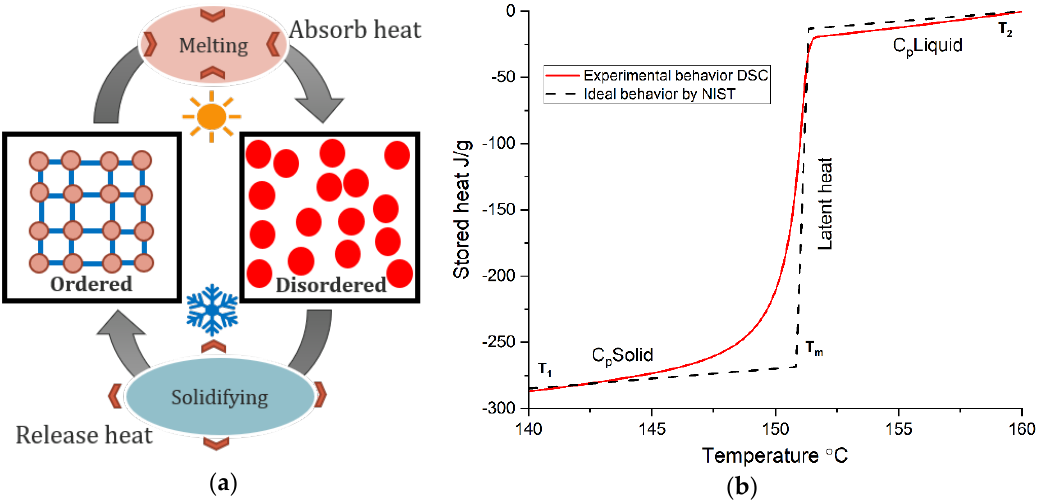
Figure 1. Solid – liquid transition in a PCM: ( a ) schematic of solid – liquid phase change; ( b ) stored heat as a function of temperature: ideal phase change of adipic acid by NIST (dashed line), actual phase change (continuous line), (personal data).